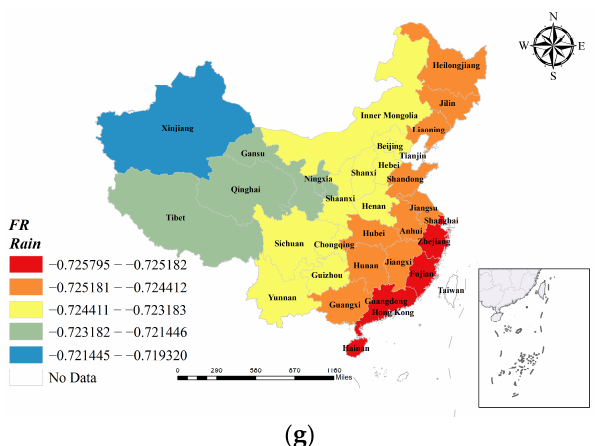
Figure 1. Spatial patterns of factors influencing Chinese adolescents’ physical fitness in 2018. ( a ) Non-farm output in the EGR group; ( b ) Rain in the EGR group; ( c ) non-farm output in the PR group; ( d ) Altitude in the PR group; ( e ) non-farm output in the FR group; ( f ) Altitude in the FR group; ( g ) Rain in the FR group.